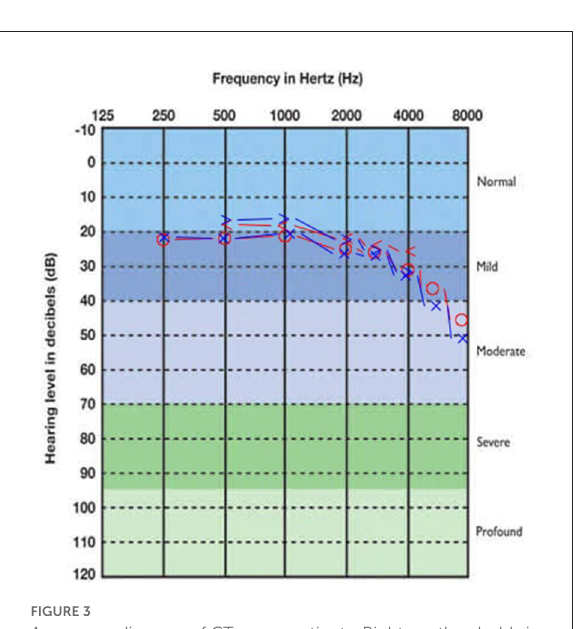
FIGURE3 Average audiogram of CT group patients. Right ear thresholds in red, left ear in blue.